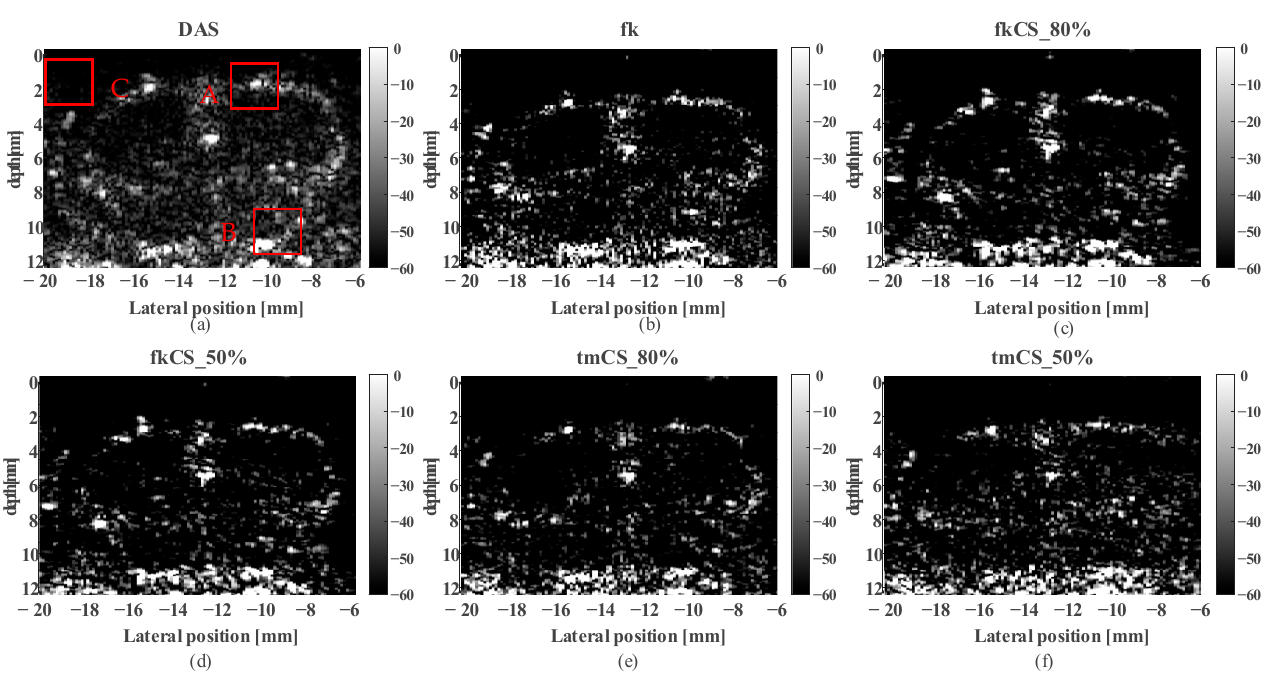
Figure 8. B mode images of rat brain scan based on different beamformers: ( a ) DAS, ( b ) Stolt’s f-k, ( c ) fkCS with compression rate of 80%, ( d ) fkCS with compression rate of 50%, ( e , f ) are tmCS with compression rates of 80% and 50%, respectively. Table 2. PSNR of brain scan experiment. Beamformer PSNR